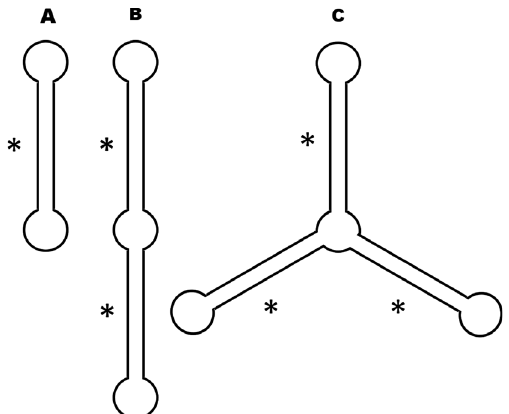
Figure 2 - Predicted secondary structures of DNA templates for multi- meric shRNAs, designed by SSD against the Apis mellifera vitellogenin gene. Circularized templates for mono- (a), bi- (b) and trivalent mshRNAs (c). Each base paired region (*) corresponds to a different shRNA.